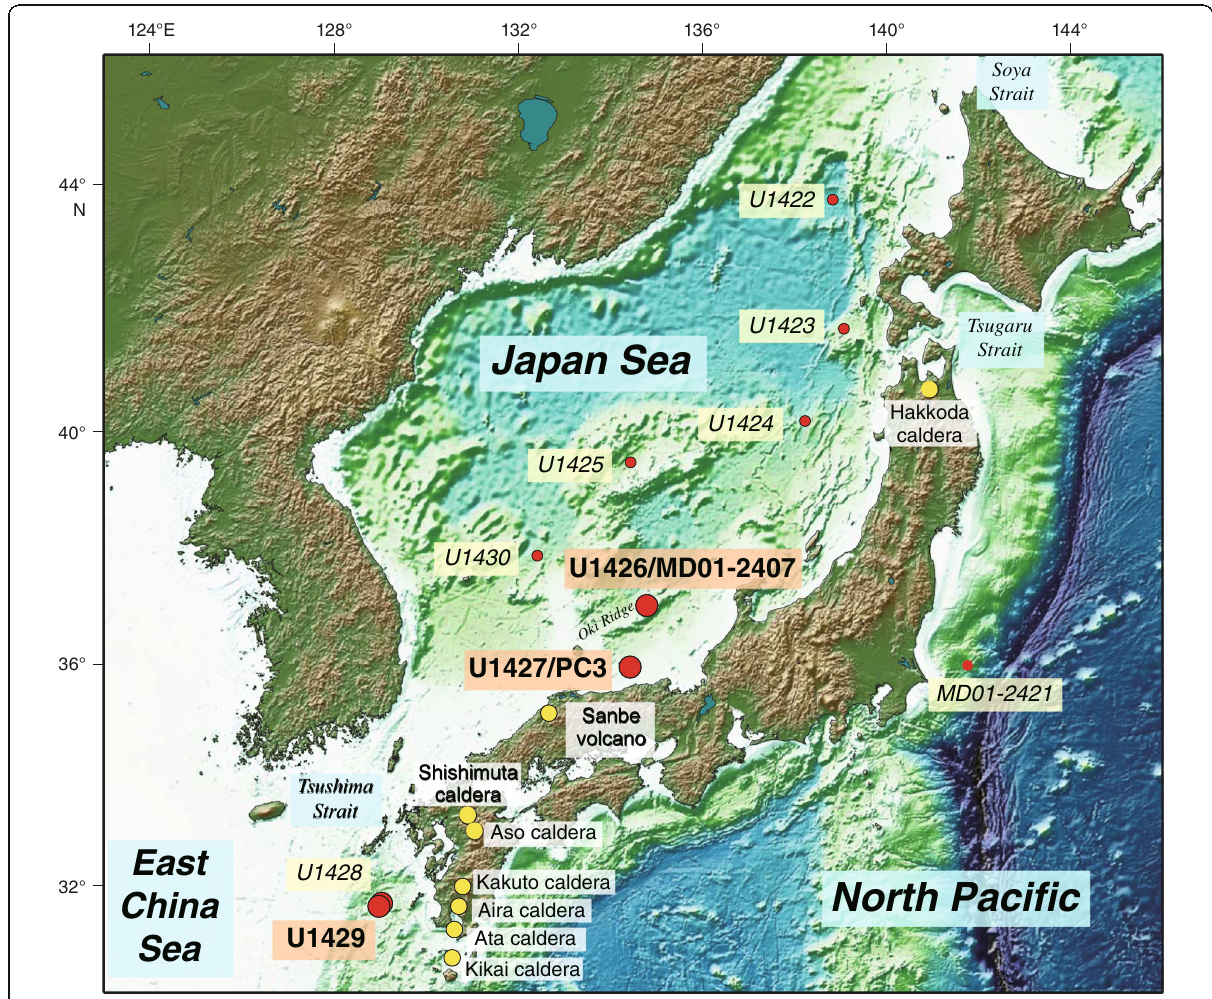
Fig. 1 Locations of sites drilled during IODP Expedition 346 in the Japan Sea and East China Sea. The source volcanoes of some of the regional tephra layers are